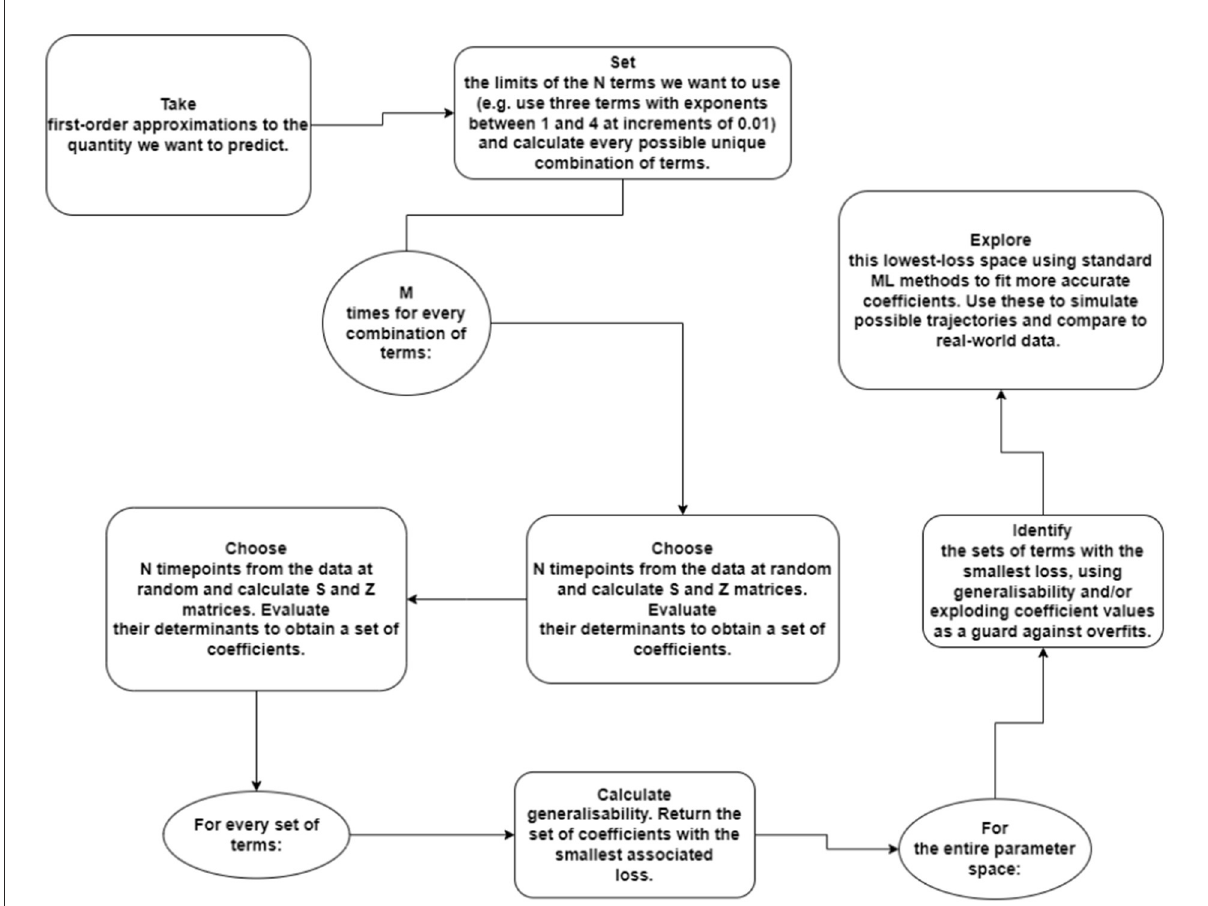
FIGURE6 Diagram of the algorithmic procedure for the preliminary investigation of physical systems. In this example, we are using an N-term polynomial with M trials each.